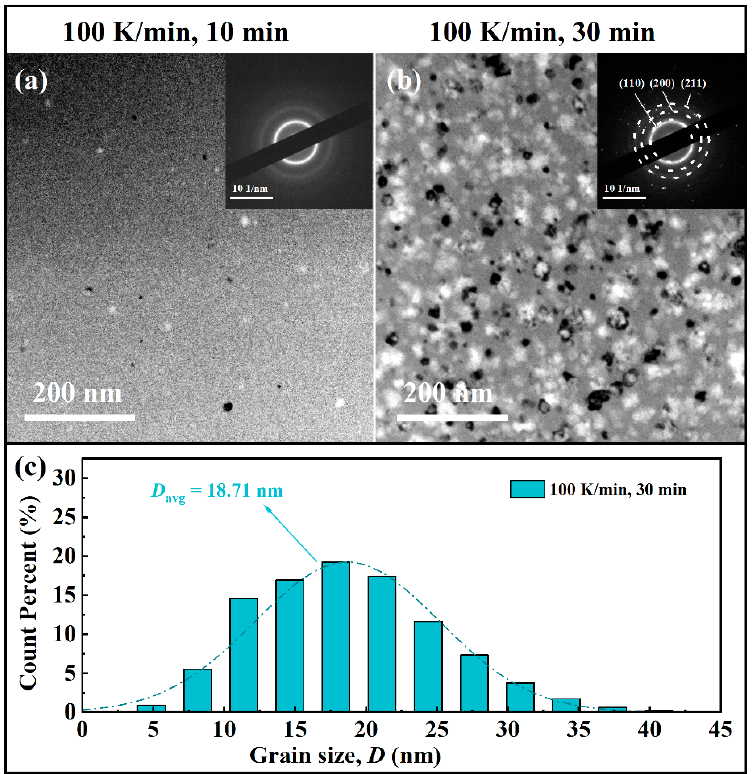
Figure 5. ( a ) μ e , ( b ) P cv , ( c ) histogram of P cv , and ( d ) H c change curve of Fe 74.75 Si 8 B 10 P 3 C 2 Nb 1.5 Cu 0.75 NPCs annealed for different HT .